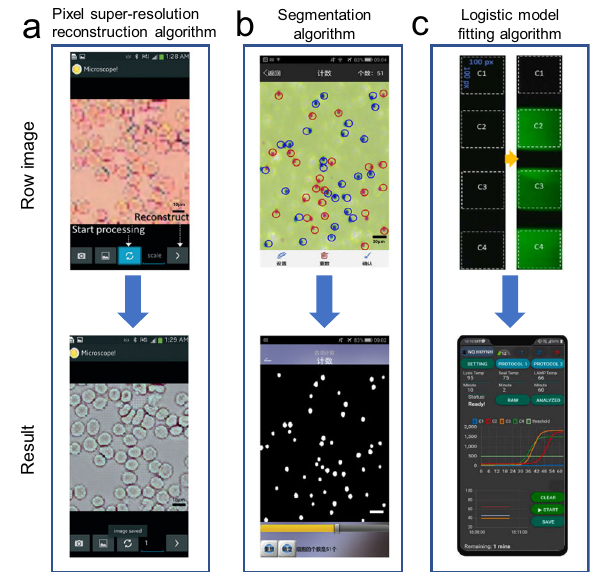
Fig. 5 | General image processing algorithms for mHealth platforms. a Pixel super-resolution reconstruction algorithm. The fi gure illustrates the use of a pixel super-resolution reconstruction algorithm to make a low-resolution image clearer ( fi gure adapted with permission from Lee et al. 59 ). b Segmentation algorithm. The fi gure illustrates the use of a segmentation algorithm to determine ROI ( fi gure adaptedwithpermissionfromZengetal. 73 ). c Thelogisticmodel- fi ttingalgorithm. The fi gure illustrates the use of the logistic model- fi tting algorithm for real-time quantitative detection of nucleic acid ( fi gure adapted with permission from Nguyen et al. 75